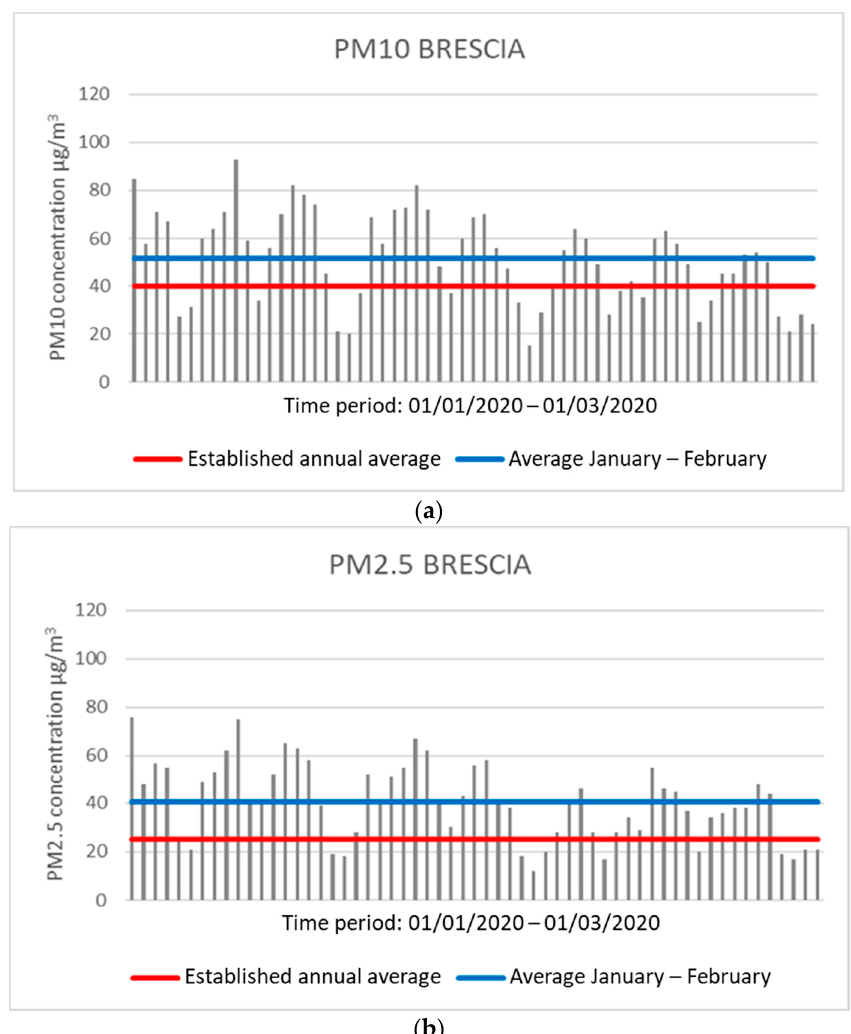
Figure 2. Graphs showing the concentration values of PM10 (a) and PM2.5 (b) in Brescia. The red line indicates the expected regulatory limit, while the blue line indicates the average in the two months analyzed (analysis processed with data collected by ARPA).